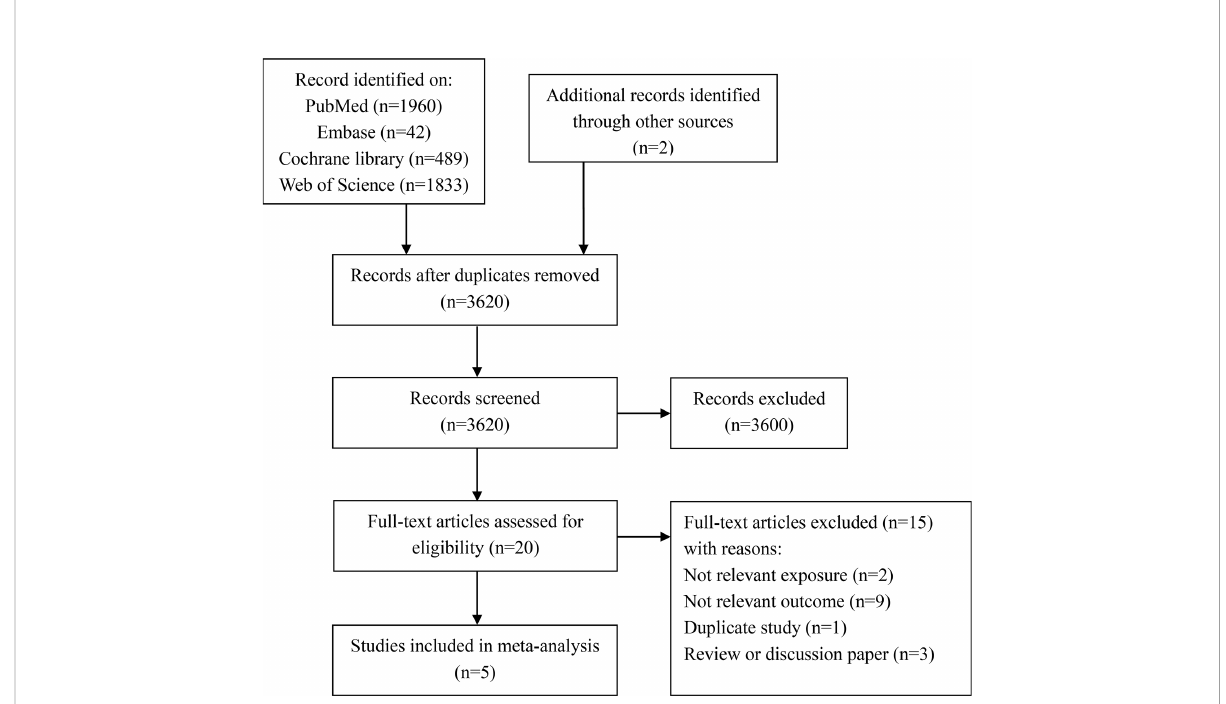
FIGURE 1 Flowchart of literature search and study selection for systematic review and